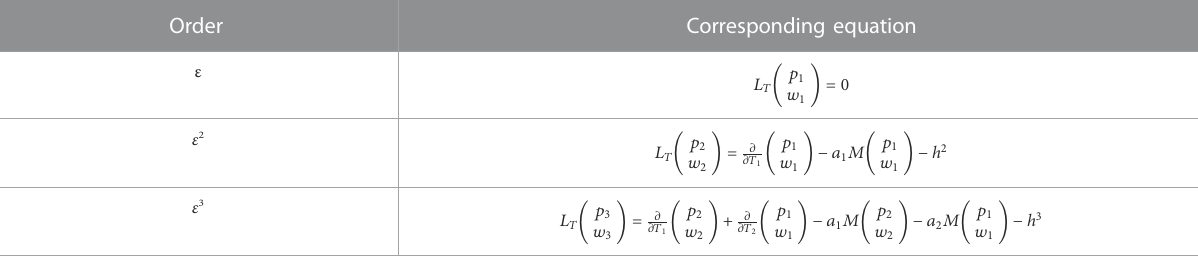
TABLE 1 Equation of different orders of ε .